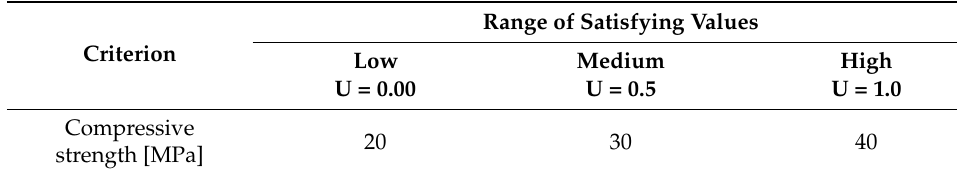
Table 7. Ranges of satisfactory values for the criterion of optimization (compressive strength) of modified silicate product with Humus Activ and Biohumus Extra